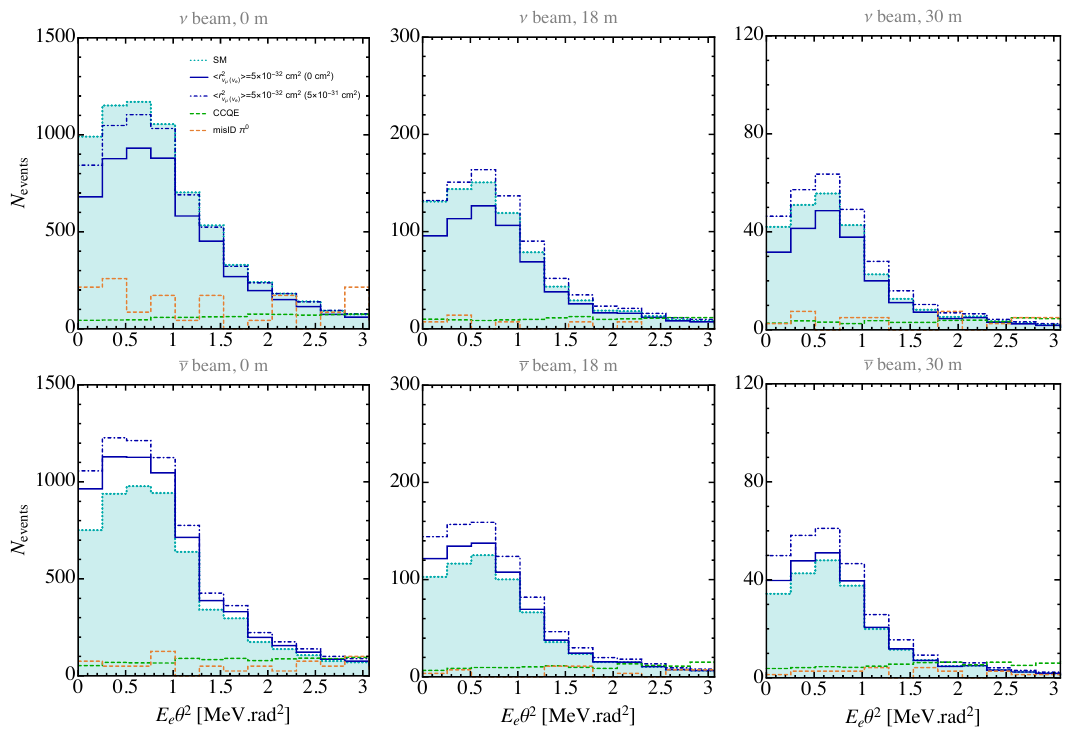
Figure 7 . This is the neutrino charge radius version of figure 2, with the same plotting